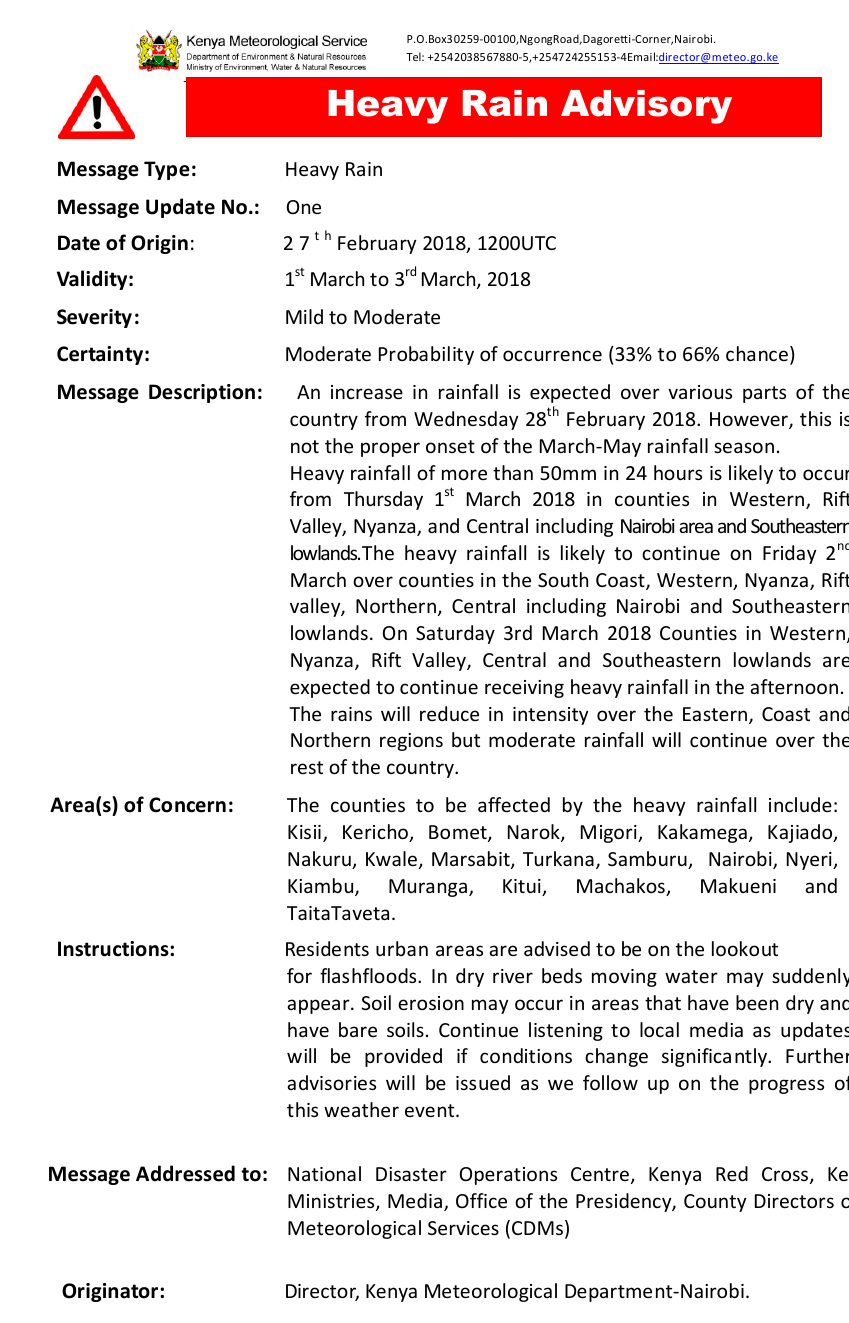
Figure 18. KMD heavy rain advisory issued 27 February 2018 for the period between 1–3 March 2018.